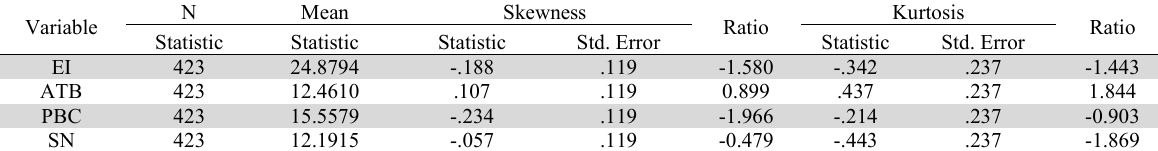
Normality Test Variable